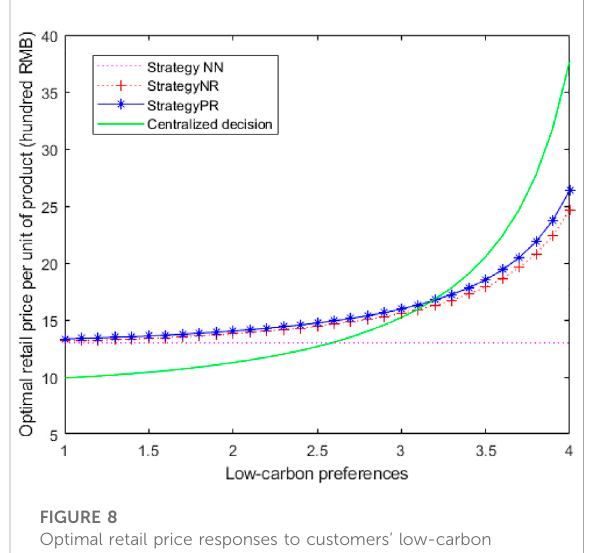
FIGURE 9 Total carbon emissions responses to customers ’ low-carbon